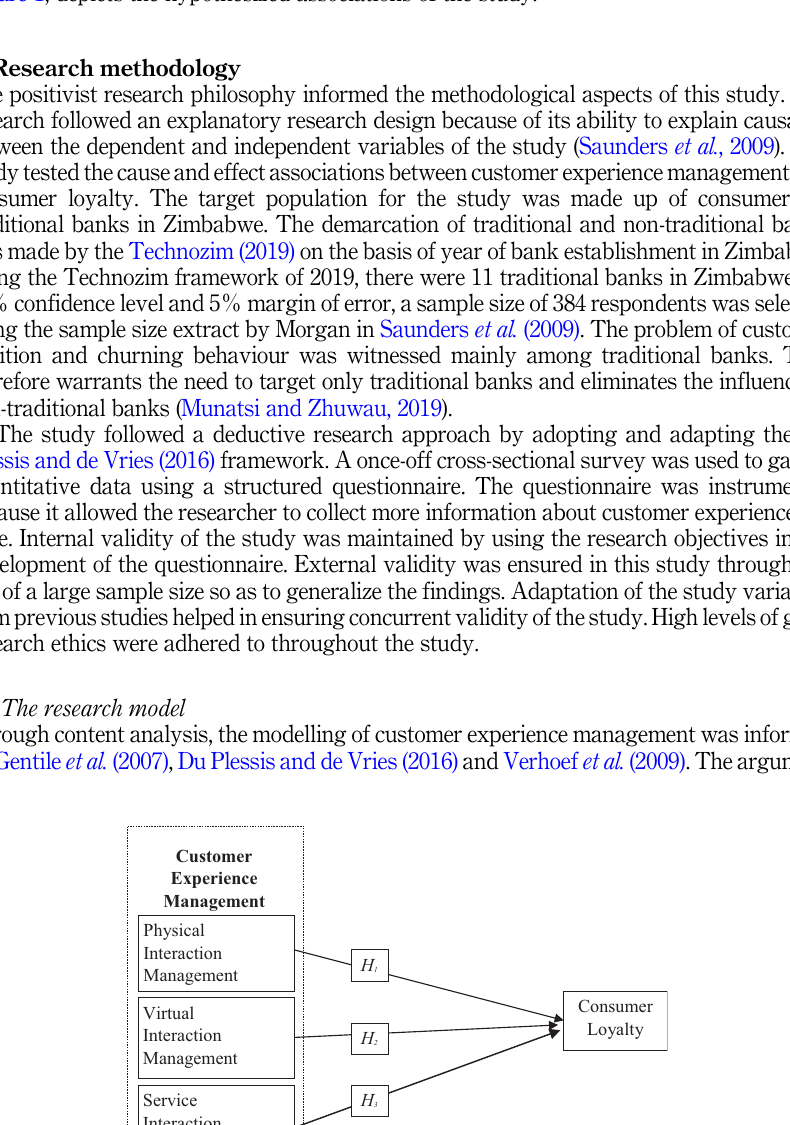
Figure 1. The conceptual framework illustrating the nexus between customer experience management and consumer